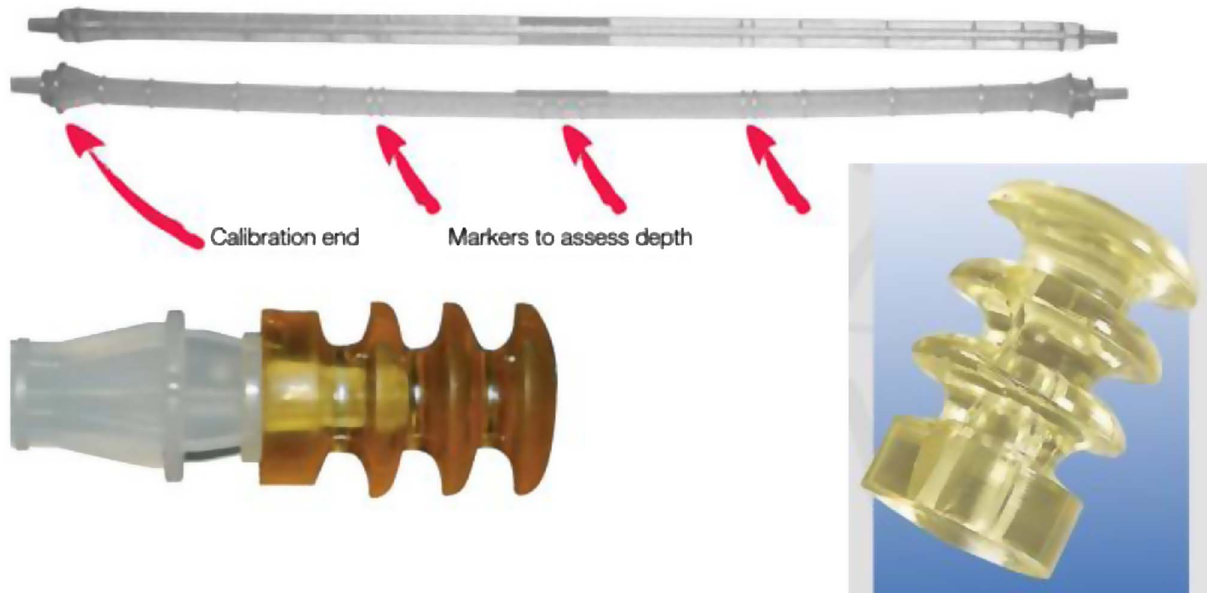
Figure 2. Single use ancillary device for APCR